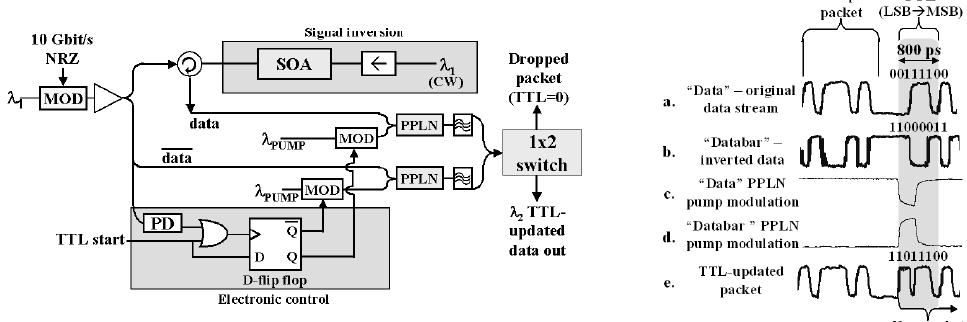
Figure 10. Optical hop count decrement implementation, using an electronic S/R FF (using an electronic data or “D” FF).